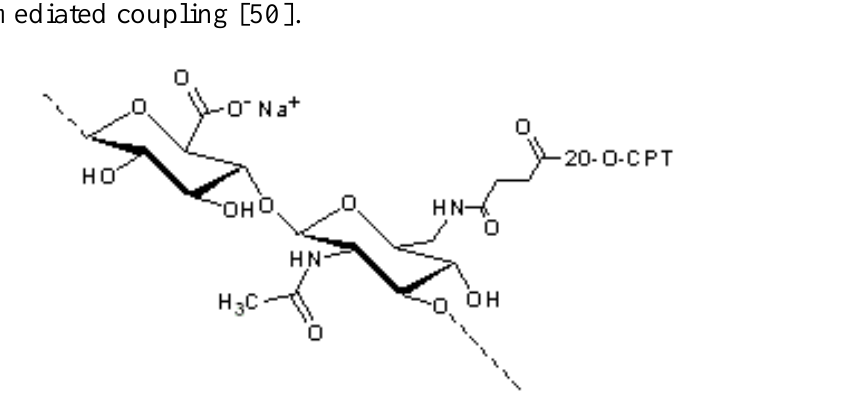
Figure 6. HA-camptothecin (HA-CPT) derivative, obtained by the conjugation of 20- O -hemisuccinate-CPT to 6-amino-6-deoxyhyaluronan derivative by a carbodiimide-mediated coupling